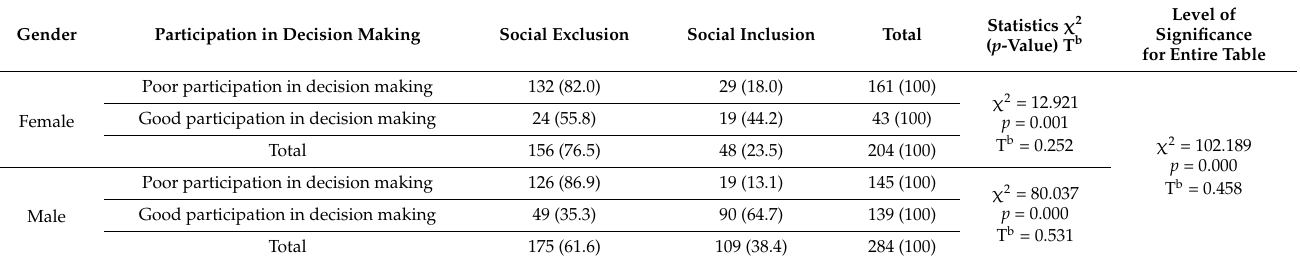
Table 3. Social inclusion of PWDs and participation in decision making while controlling